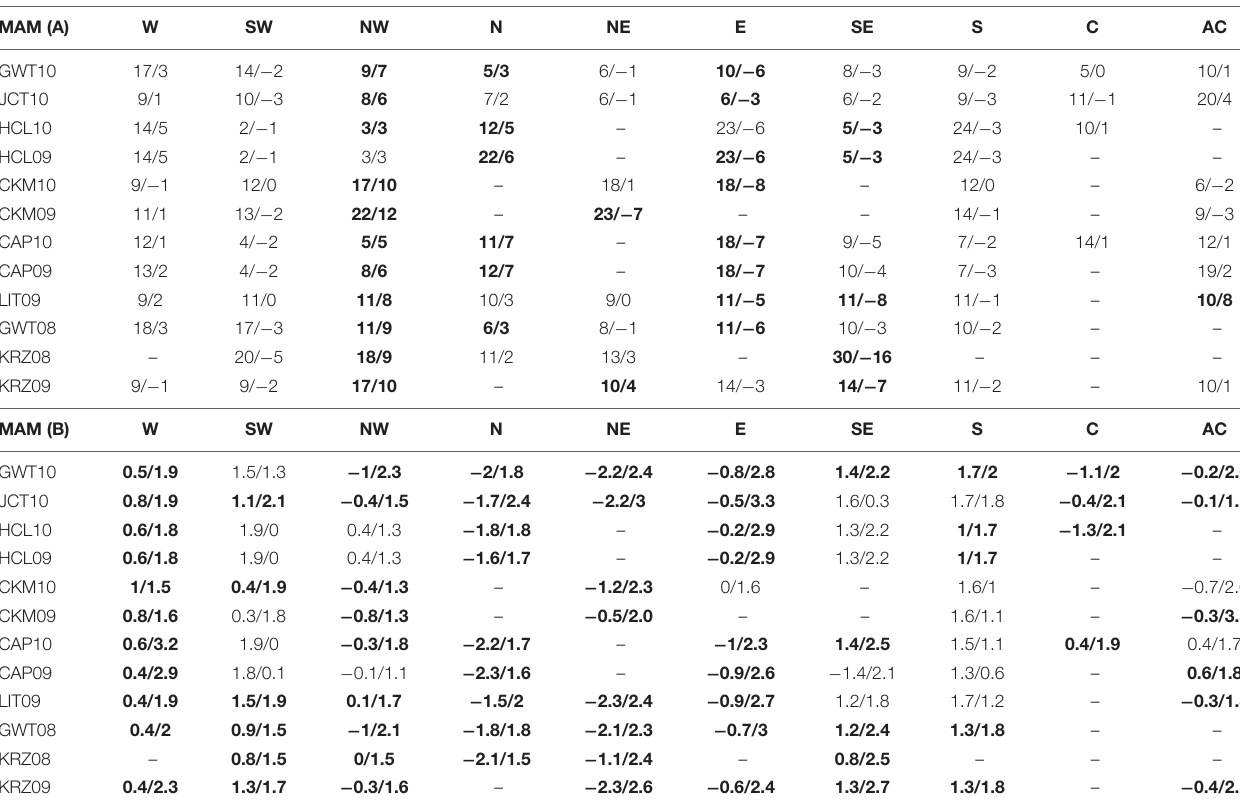
TABLE 5 | Long-term average (1966–2015) frequency of circulation types (in days) and changes by trend line in days in spring [MAM (A)] and long-term average air temperature anomalies associated with circulation types at Türi station and changes by trend line in ◦ C in spring [MAM (B)]. MAM (A) W SW